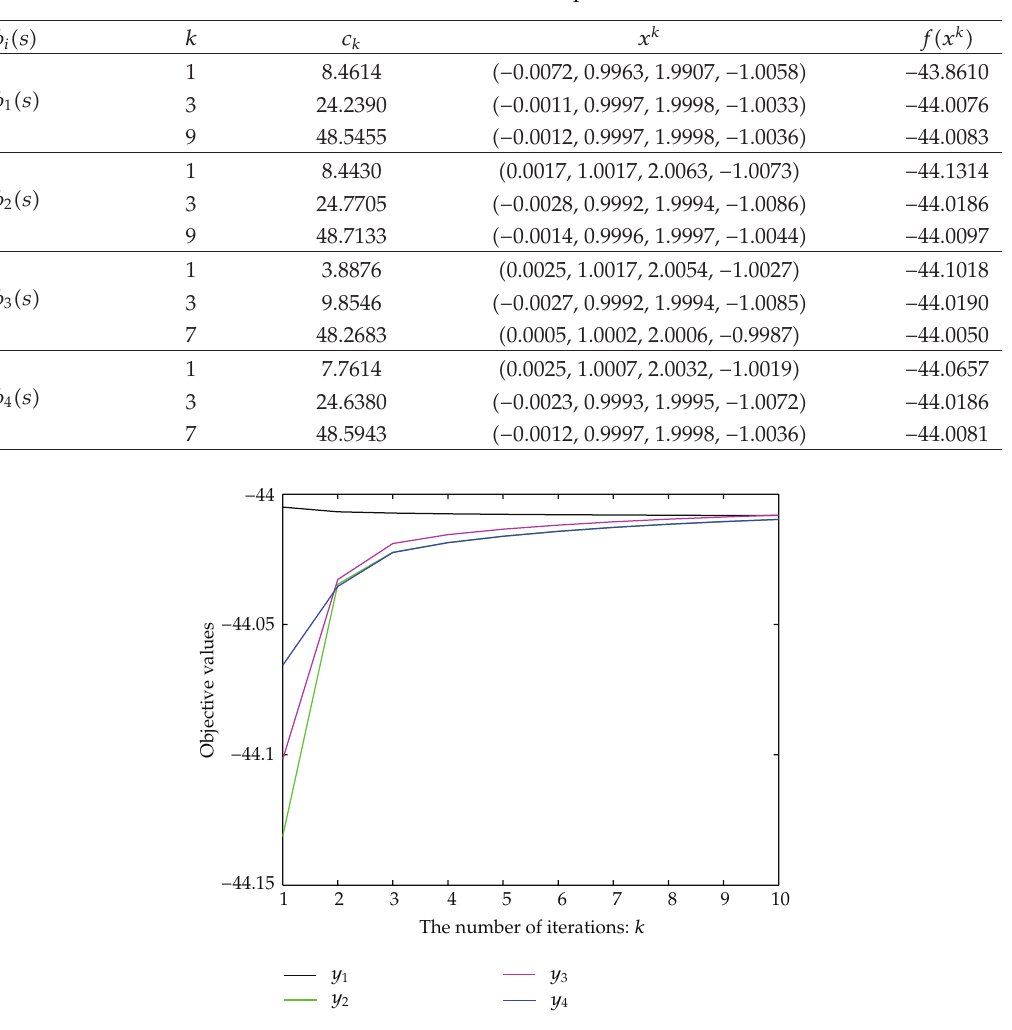
Table 2: Result of Example 3.2.